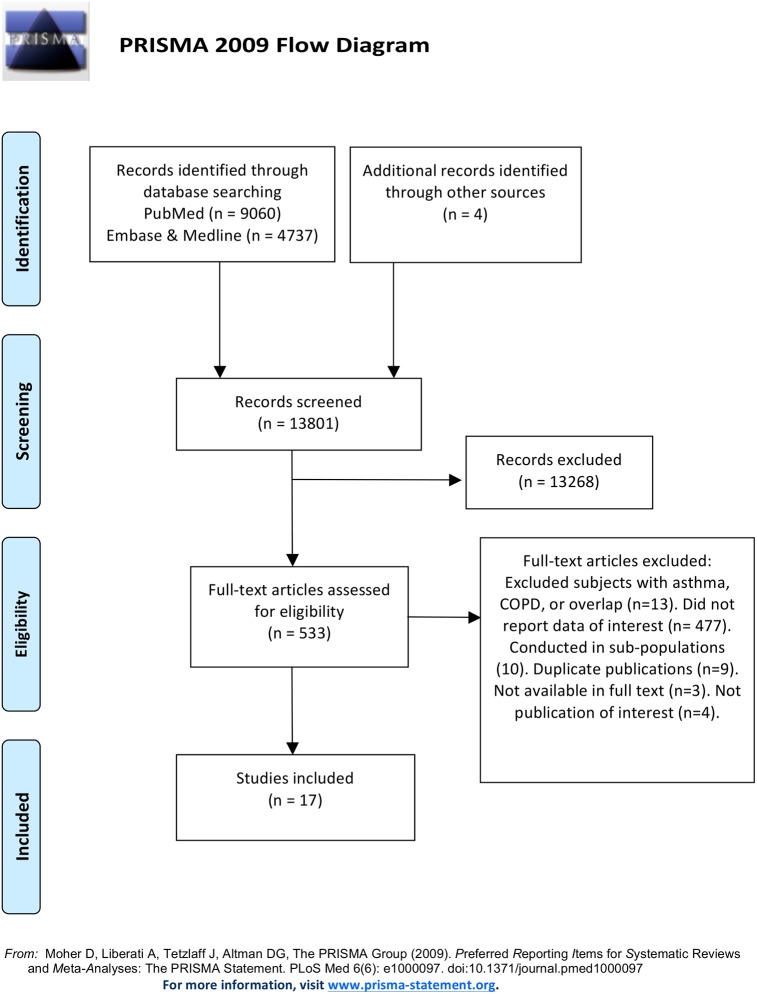
Review process (PRISMA Flow Diagram): details of review process.